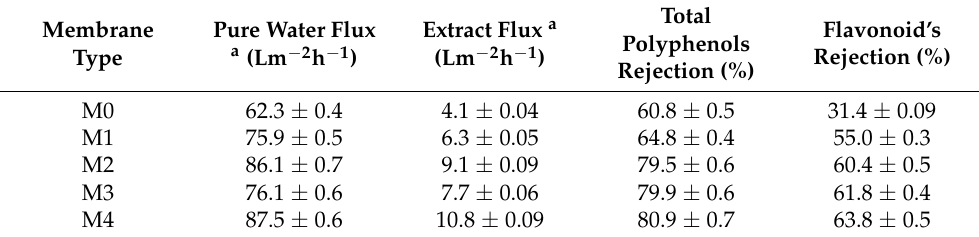
Table 2. Permeation performance and rejection for total polyphenols and flavonoids from Chaenomeles japonica fruits extract for the prepared membranes.